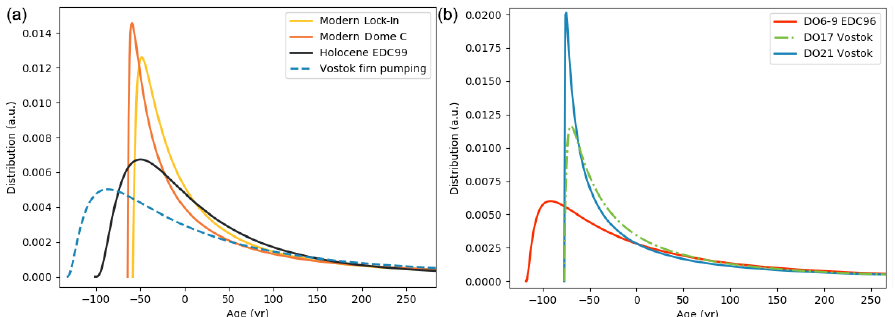
Figure 8. Gas age distributions in various ice cores. In order to be more easily compared, the age distributions are all drawn relative to their median gas age. This is why parts of the distributions have negative ages in the graph. (a) Displays of Holocene GADs and (b) glacial period GADs. The DO21 Vostok, DO6-9 EDC96, Holocene EDC99, modern Lock-In and Dome C age distributions shown as solid lines were determined in this study. The dashed DO17 Vostok distribution was also determined by comparison with a high-accumulation record (Fourteau et al., 2017). The dashed Vostok firn pumping distribution was obtained with a gas trapping model, constrained with firn air pumping data (Witrant et al.,